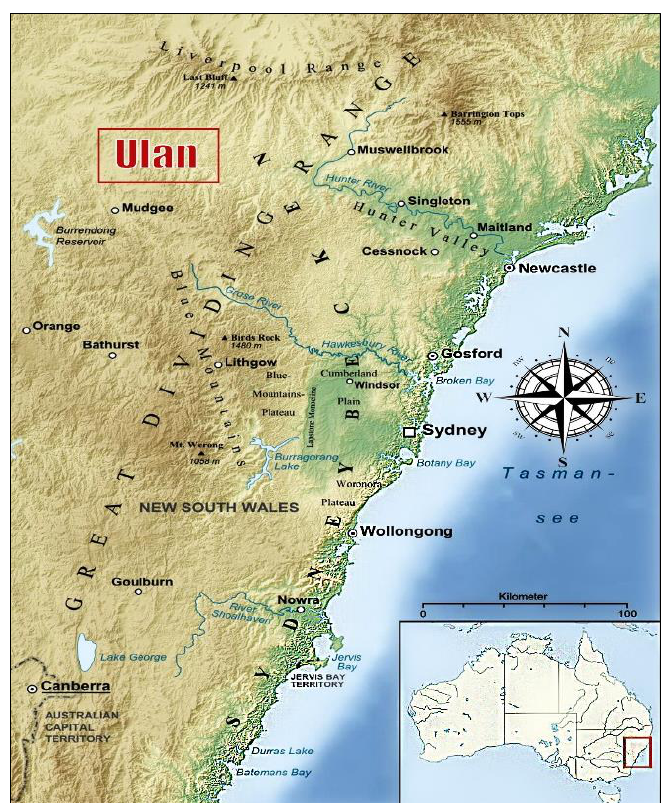
Figure 9: locality of the Ulan coal mines complex. Source: